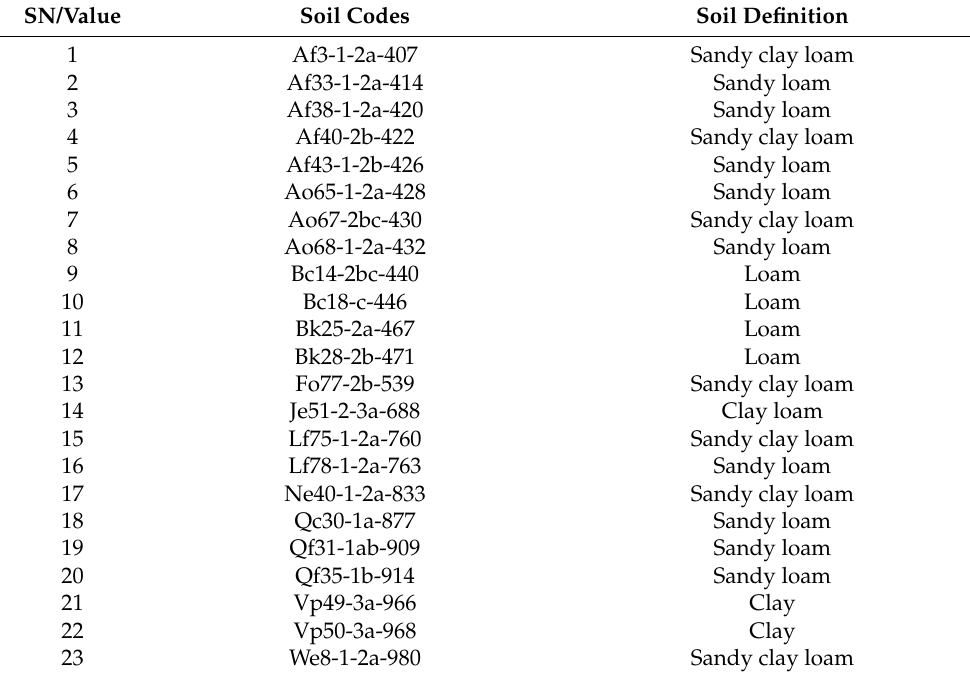
Table 1. The major soil types existing in the WRB and their